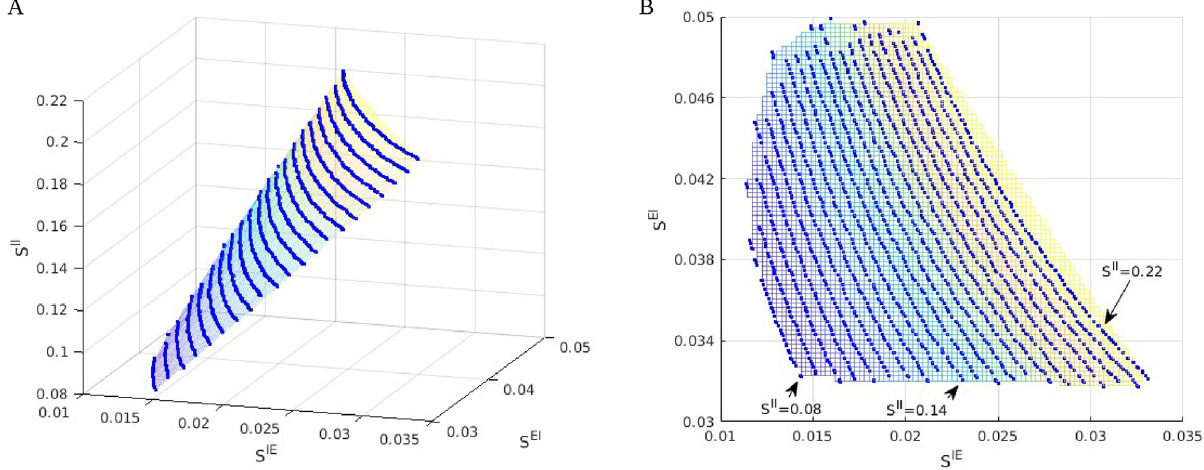
Fig 6. Other views of the viable regions. A. A 2D surface approximating the viable region projected to the 3D-space defined by S IE × S EI × S II . Blue lines are projections of contours for f = 4 Hz intersected with the good areas, computed on 21 different inhibition planes. Parameters are fixed at S EE = E 0.024, S E lgn / S EE = 2, S I lgn / S E lgn = 2, and F I L6 / F E L6 = 2; S II varies from 0.22 for the top contour to 0.08 for the bottom contour. B. A bird’s eye view of the left panel, with colors indicating corresponding locations of the projected